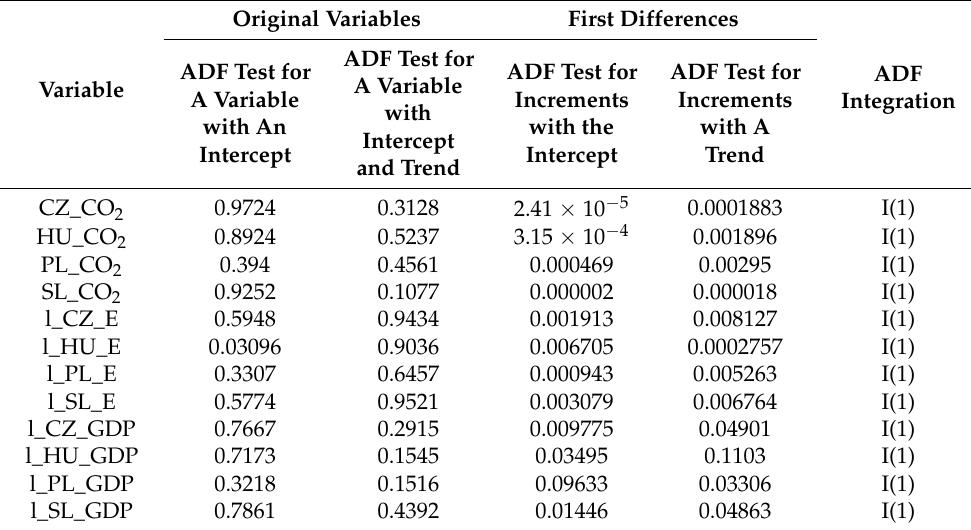
Table 3. Unit Root Test—ADF Test